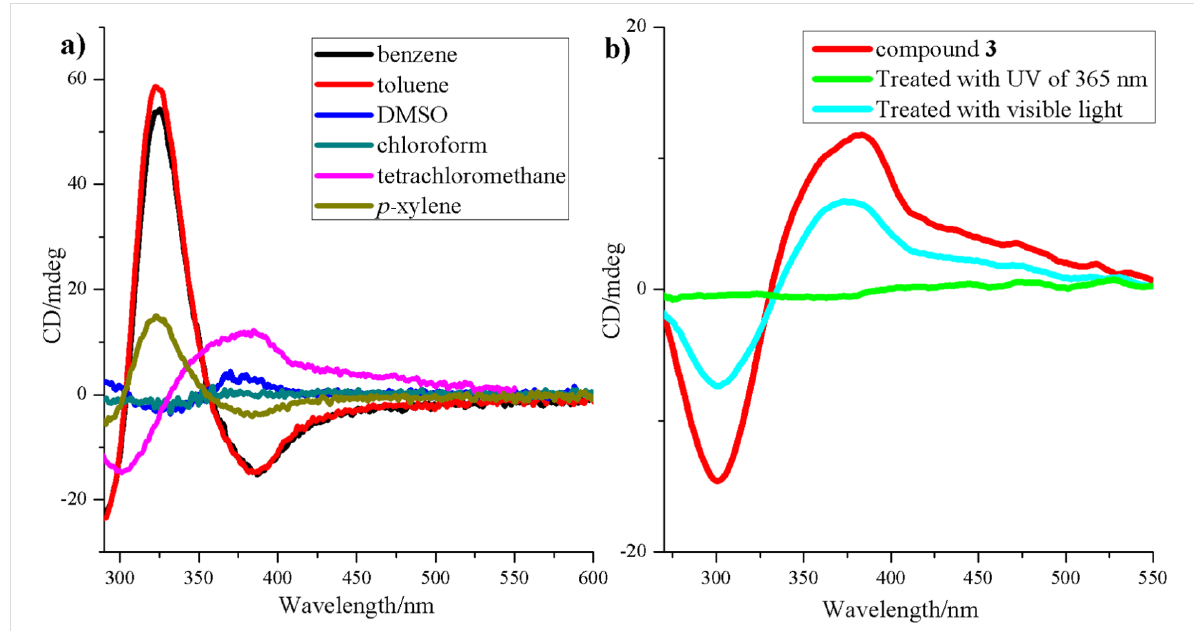
Figure 3: CD spectrum of compound 3 in solutions of a) benzene, toluene, p -xylene, chloroform, tetrachloromethane and DMSO with identical con- centration (3.0 × 10 − 5 M), b) before and after being exposed to UV ( λ = 365 nm) and visible ( λ = 420 nm) light.